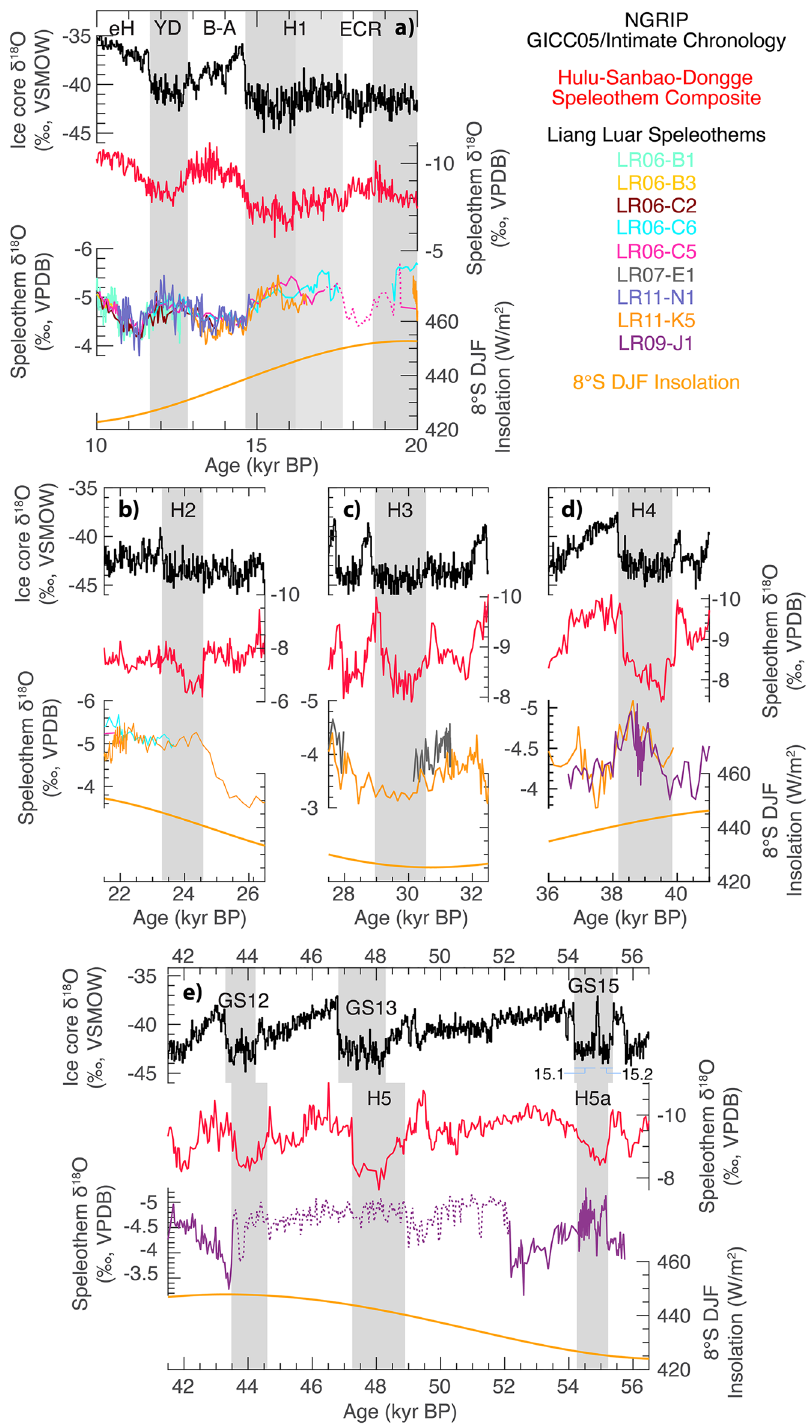
Figure 4. Isotopic responses to Heinrich events. Top to bottom in each panel: NGRIP ice core δ 18 O (black 47 ), composite speleothem δ 18 O for China (red 34 ), individual speleothem δ 18 O records for Flores (colours as shown in legend) and southern summer insolation (JJA) at 8°S (orange). Dotted lines indicate presence of aragonite or non-primary calcite